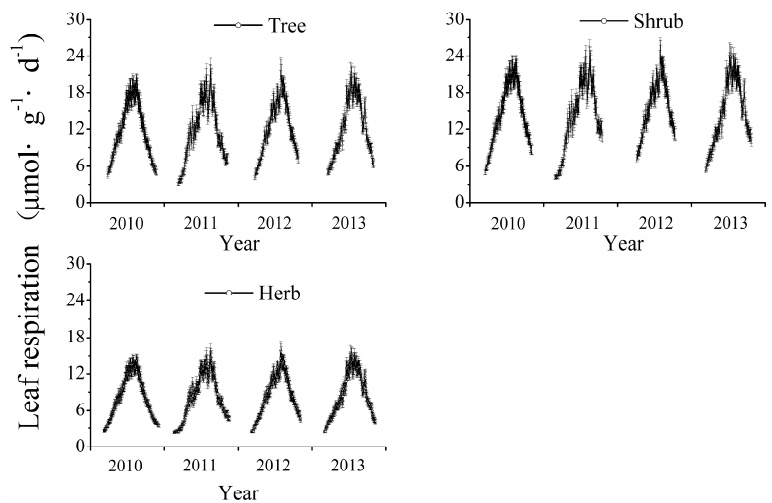
Figure 4. Daily mean leaf respiration for trees, shrubs, and herbs in the L. principis-rupprechtii forest during 2010–2013. Error bars are based on 0.5 h air temperatures as experimental unit ( n = 48).